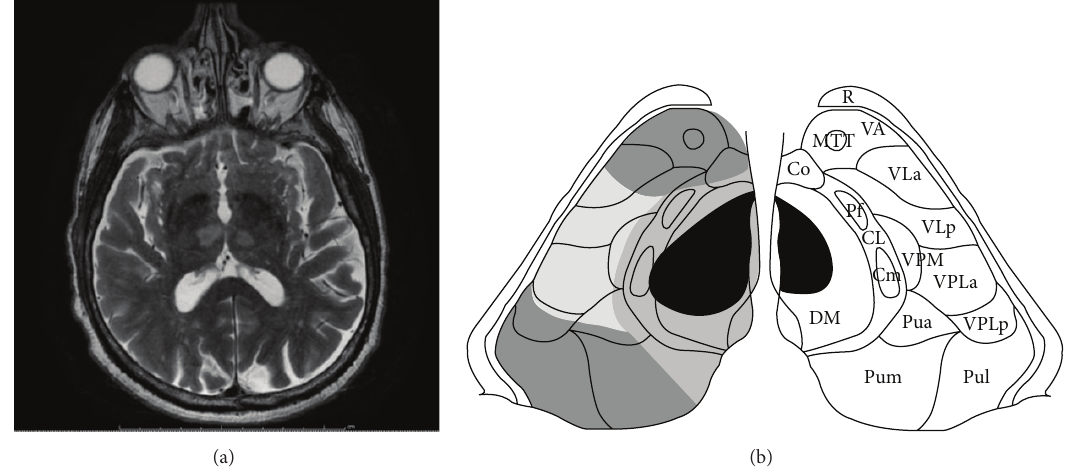
Figure 3: (a) T2-weighted MRI showed a bilateral paramedian; it was done the same day when patient became comatose on July 16, 2015. Patienthasamnesiaaccompanyingconfabulationafterthealteredmentalstatusresolved.(b)Schematicrepresentationofthelesioninbilateral thalamic DM and IL nuclei (see Figure 1 for legend for